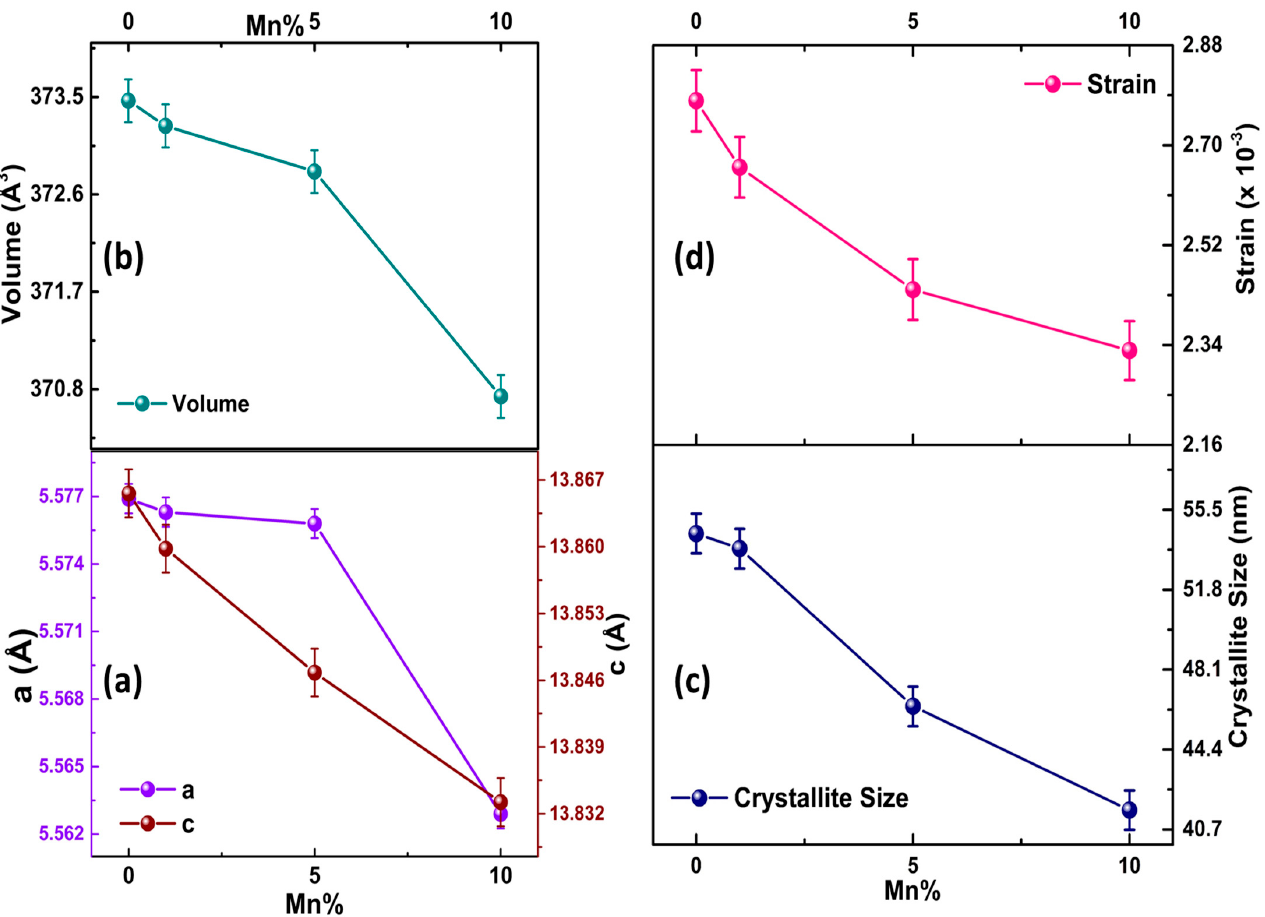
Figure 3. The values of the structural parameters; ( a ) lattice parameters (a = b)/c; ( b ) cell volume; ( c ) crystallite sizes; and ( d ) strain plotted as a function of Mn concentration. Table 1. Structural parameters and secondary phase fraction obtained from Rietveld refinement of XRD patterns.